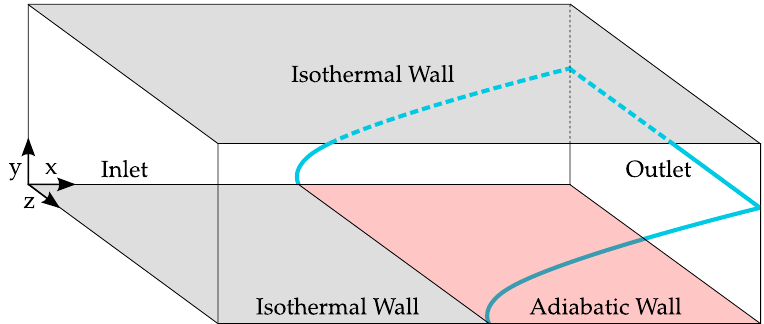
Figure 1. Computational domain and stable flame shape for reactive